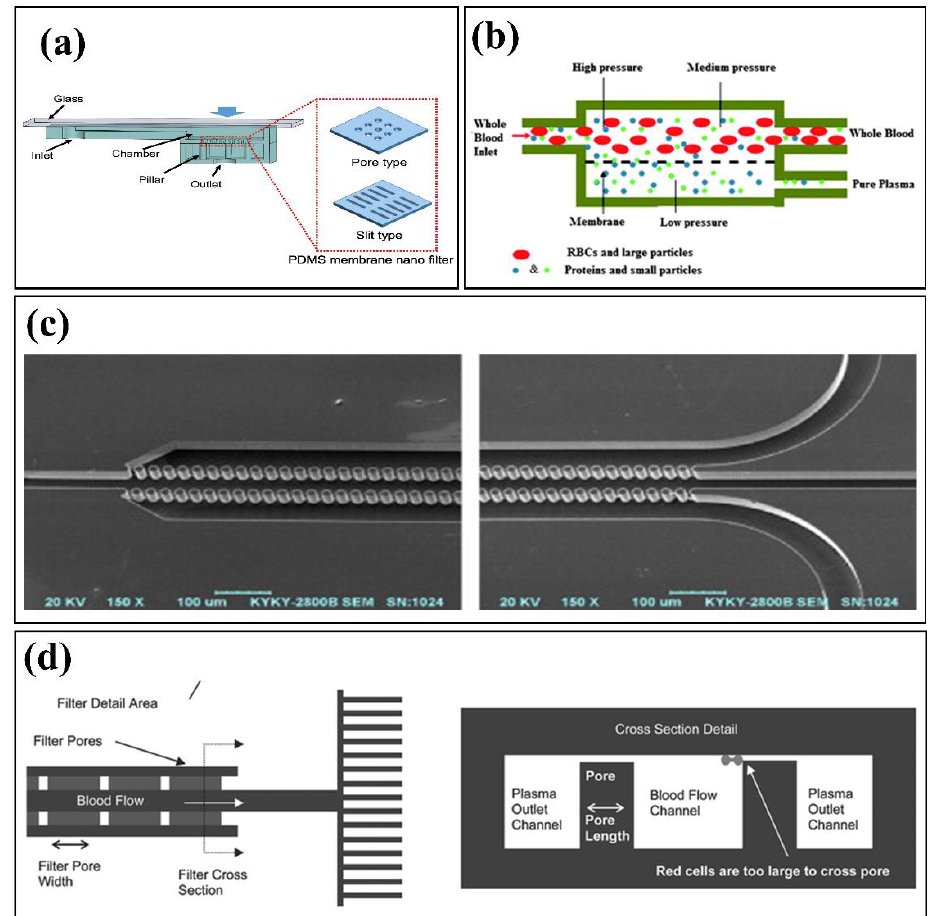
Figure 2. Microfiltration examples: ( a ) Dead-end membrane-based filtration, adopted with permis- sion from [29], Copyright 2019, Elsevier; ( b ) Cross-flow membrane-based filtration, adopted with permission from [33] Copyright 2011, Royal Society of Chemistry; ( c ) Cross-flow pillar-based filtra- tion, adopted with permission from [30], Copyright 2008, Elsevier; and ( d ) Cross-flow weir-based filtration, adopted with permission from [31], Copyright 2005, Royal Society of Chemistry.